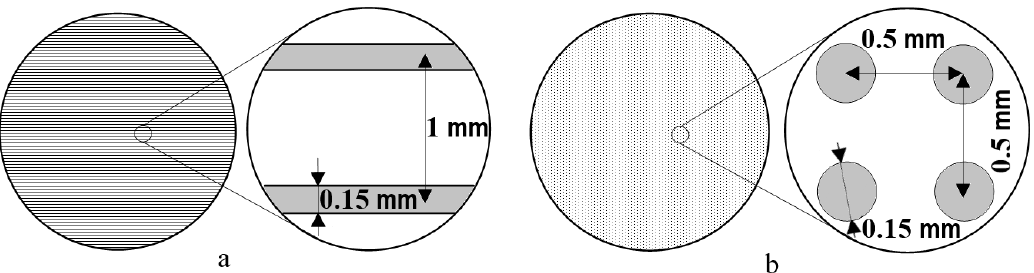
Figure 1. Graphic scheme of laser processing: ( a ) — continuous and ( b ) — quasi-pulse laser irradia-